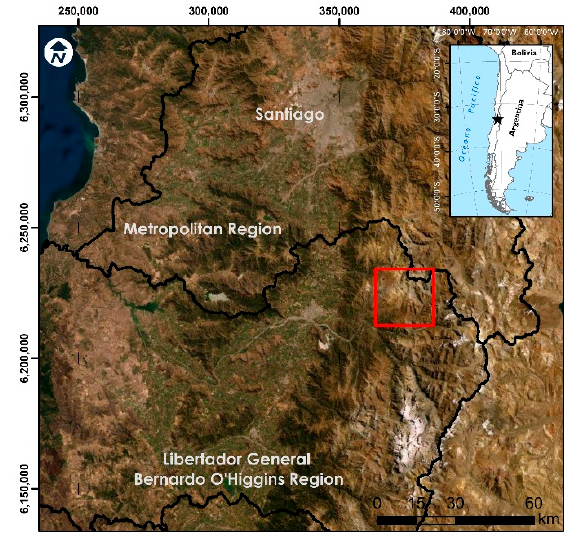
Figure 1. Study area. The red rectangle shows the study area.